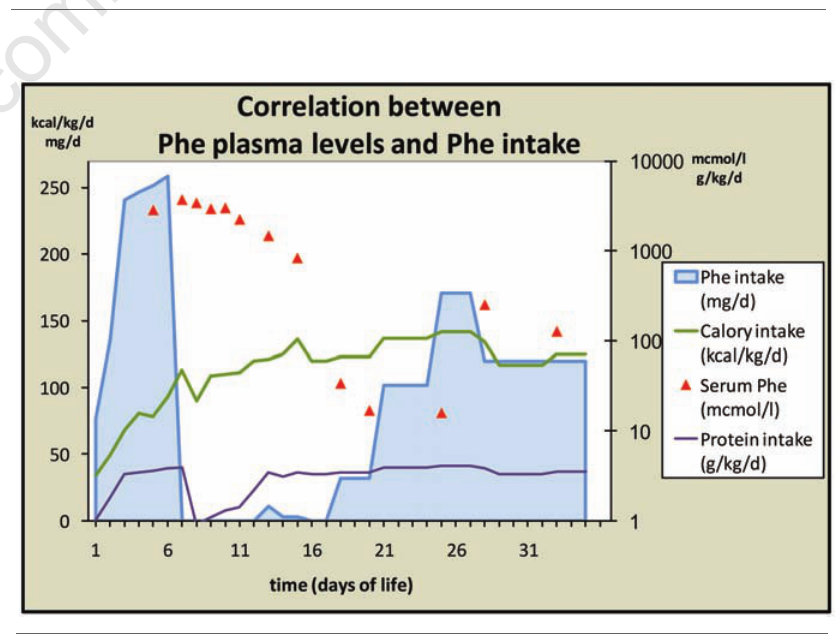
Figure 2. Correlation between phenylalanine plasma levels and phenylalanine intake during the first 35 days of life: Phenylalanine intake (mg/d) is given in light blue, total protein intake (g/kg/d) in dark blue, calorie intake in green and plasma phenylalanine levels in red triangles.